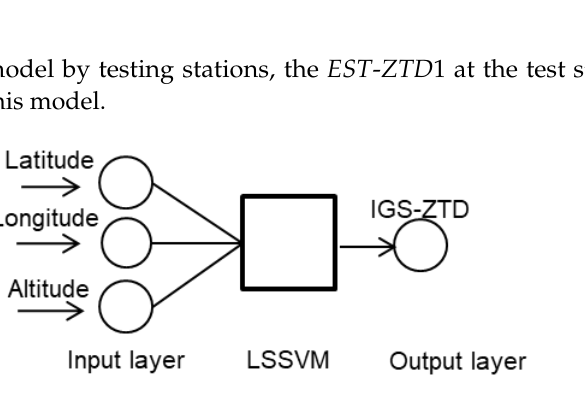
Figure 1. Network structure of Schemes 1.